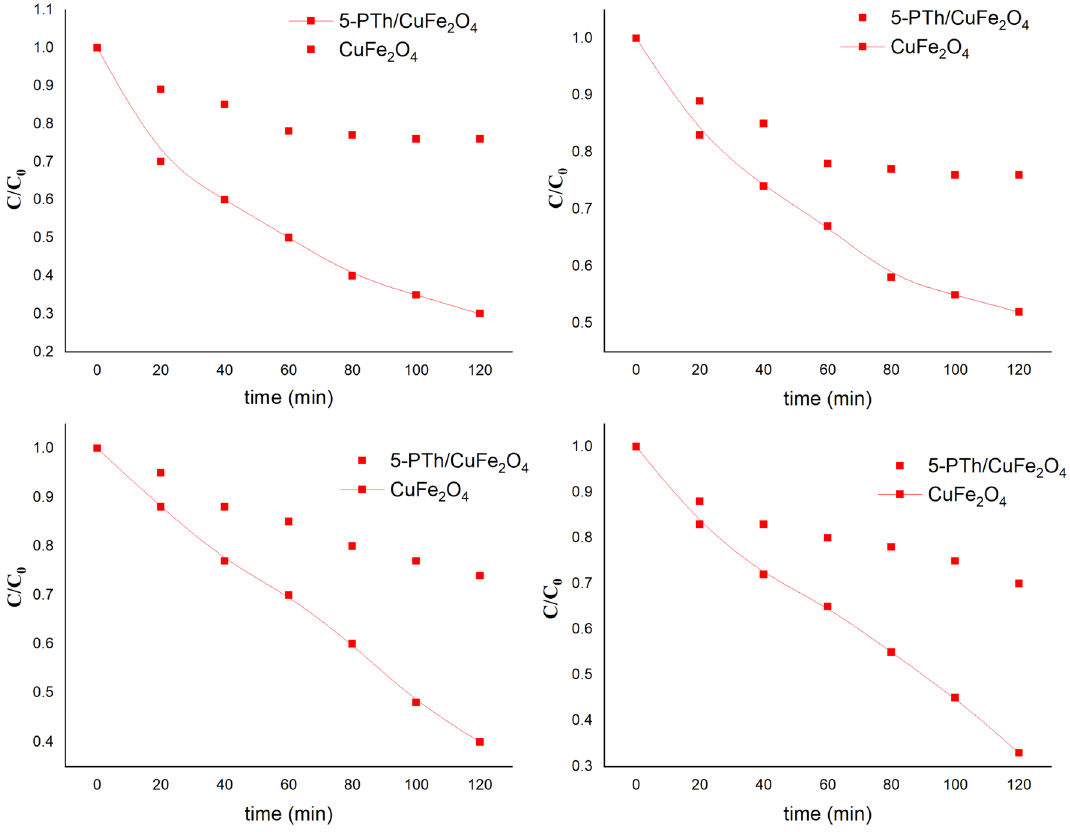
Figure 6. Recyclability test using CuFe 2 O 4 and 5-PTh/CuFe 2 O 4